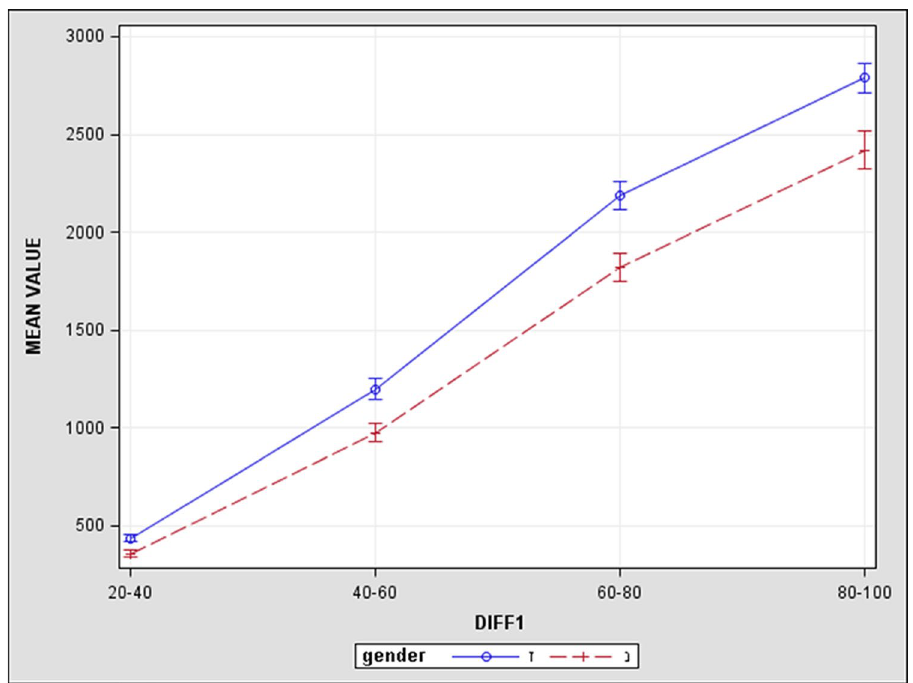
Figure 3. The blue line represents the results of male patients and red dashed line represents results of female patients. The X axis—represents points of calculated differences between the retrobulbar orbital volumes, they are shown at equal distances from each other. The Y axis—represents subtraction differences in the nearest retrobulbar orbital volumes in mm 3 . The numeric value of subtraction differences of volumes being smaller